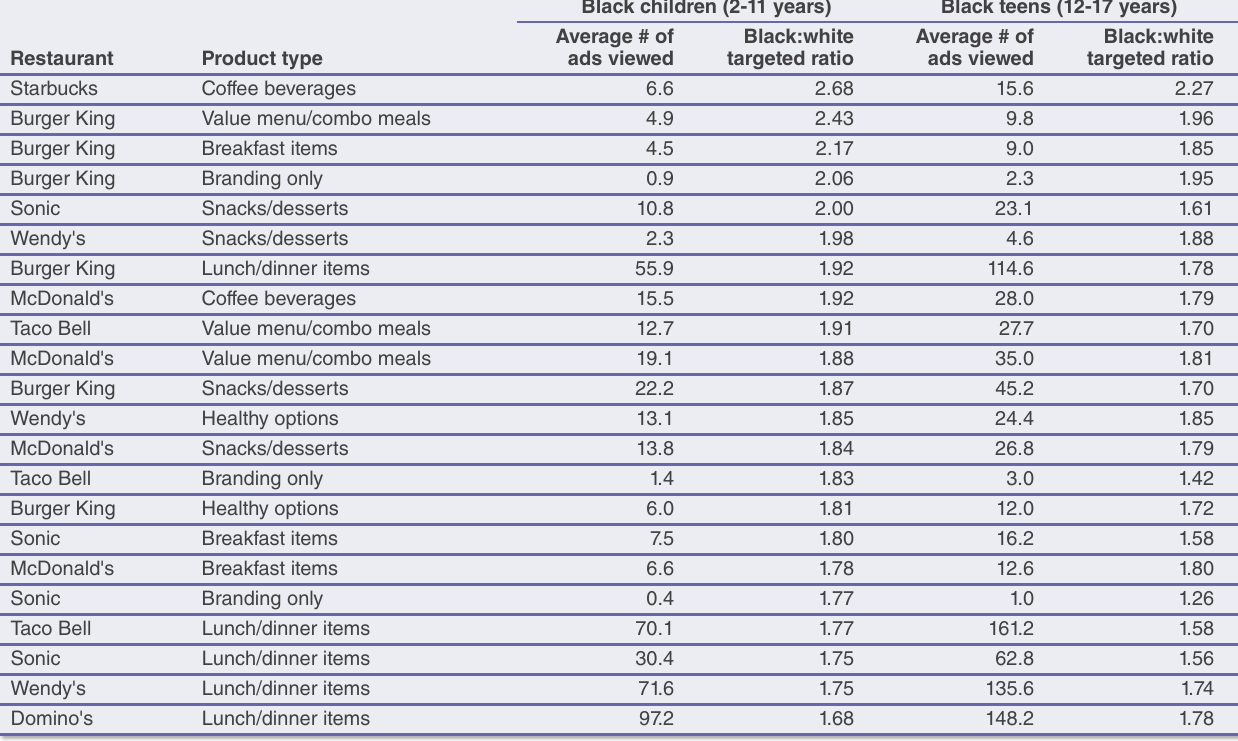
Table 42. Restaurant product types with the highest black:white targeted ratios